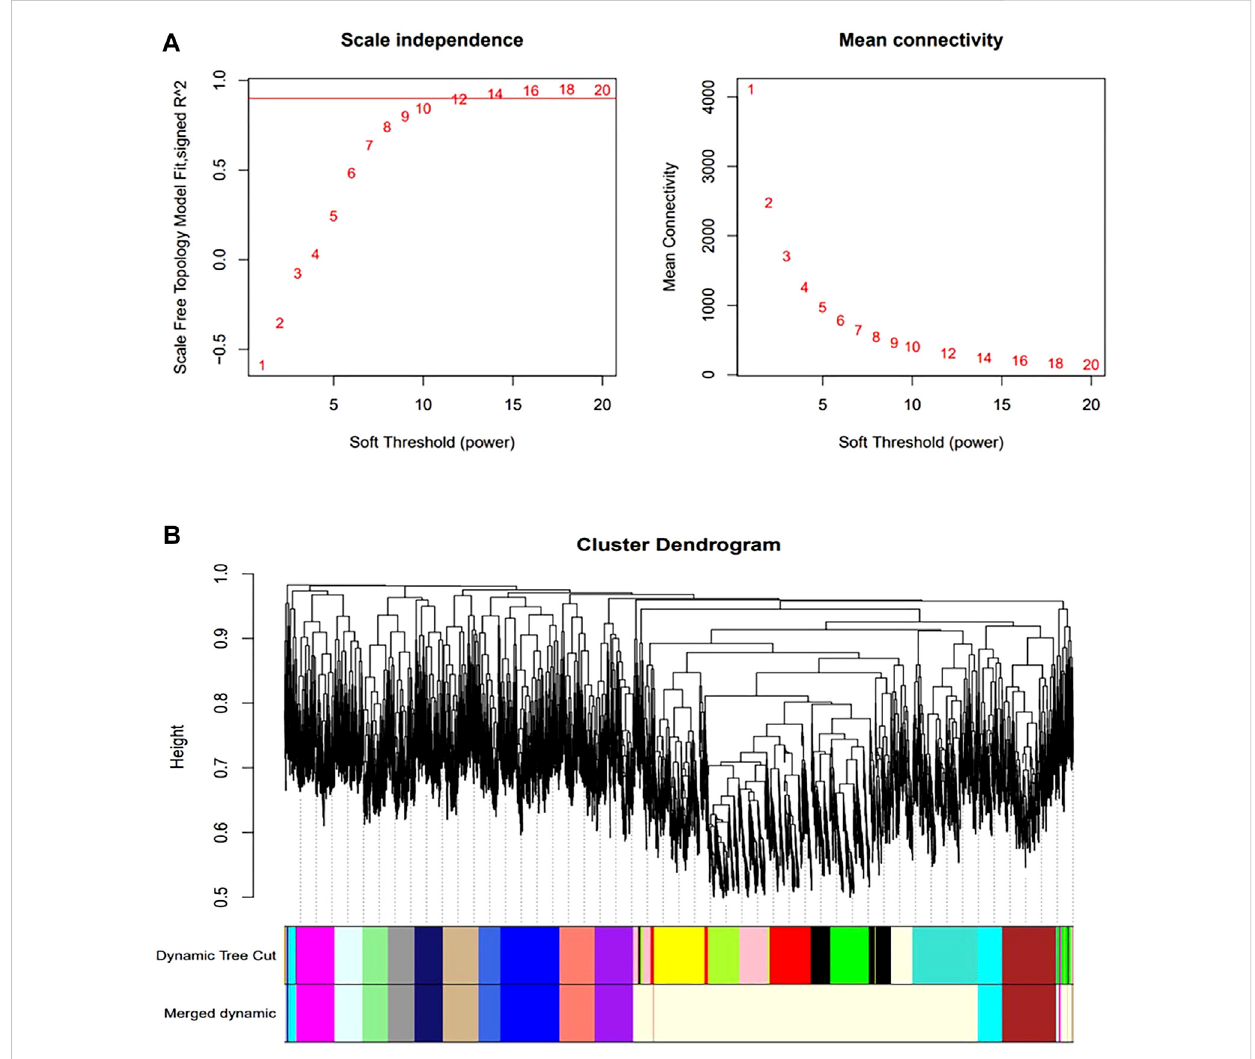
FIGURE 4 Construction of co-expression network. (A) Determination of optimal soft threshold (during module selection, the adjacency matrix was transformed into a topological matrix to determine the optimal soft threshold β = 12); (B) Clustering tree of co-expressed gene modules (similar genes were grouped into the same module by dynamic splicing and cluster